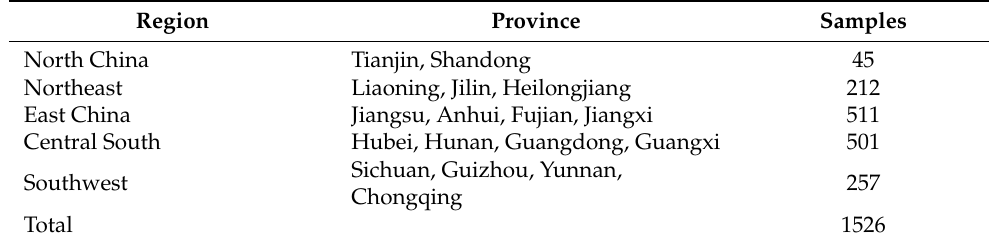
Table 1. Sample distribution.